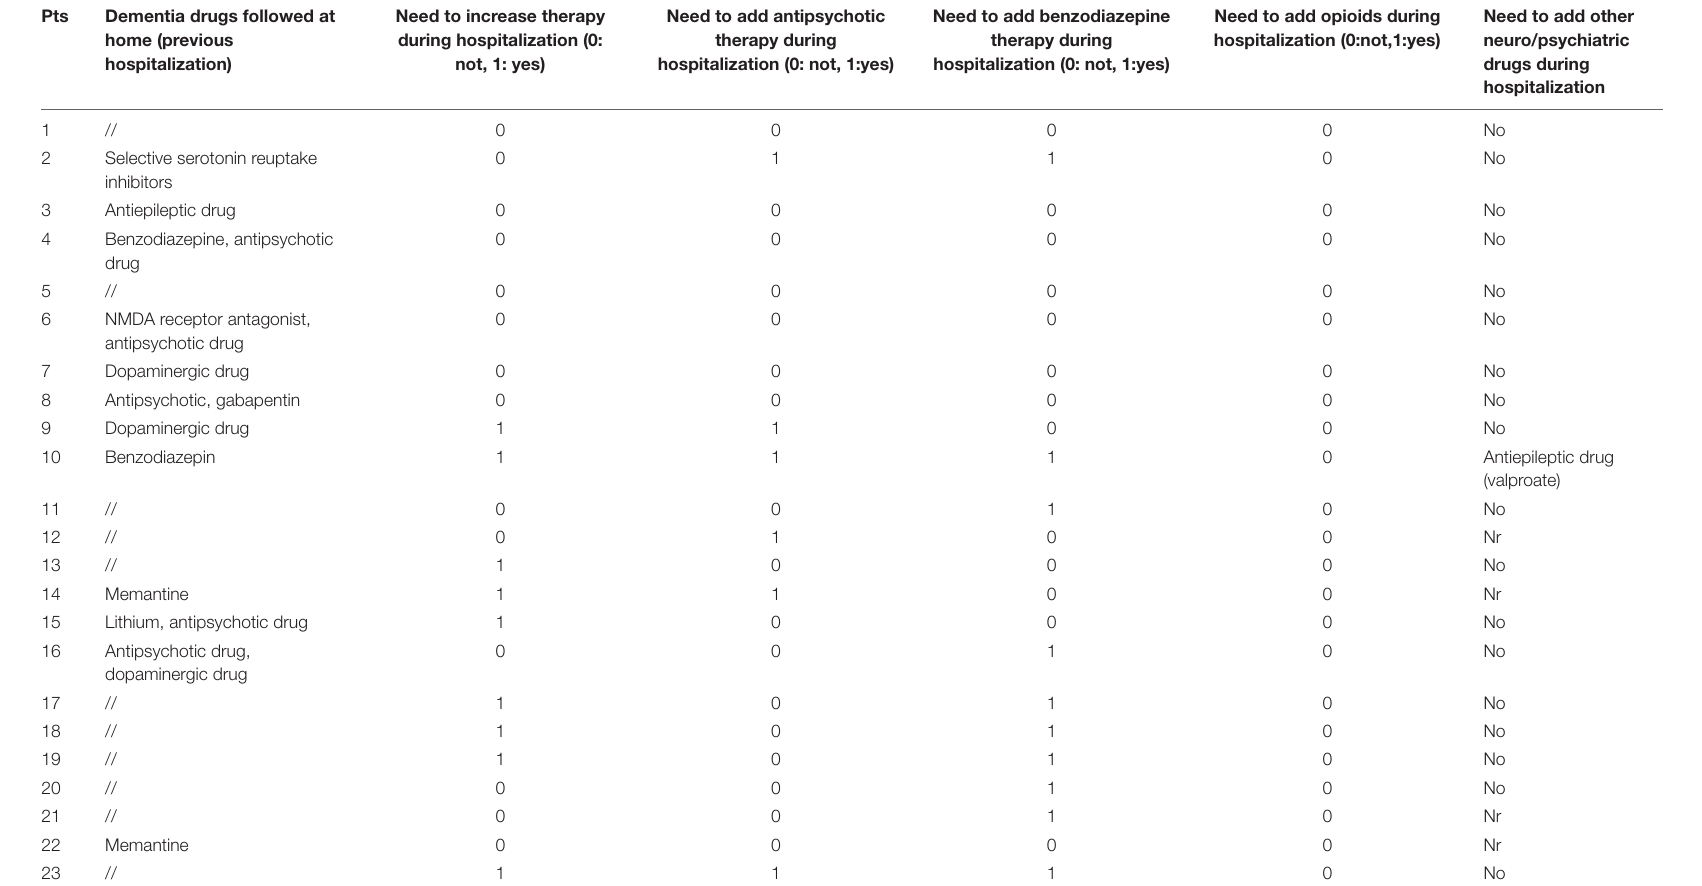
TABLE 1 | The therapies of the patients in case group.